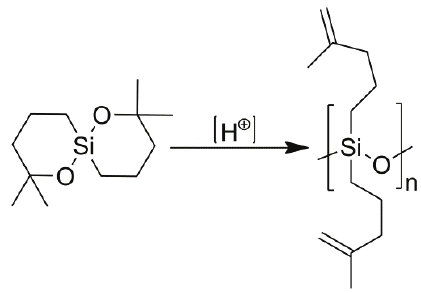
Figure 23. The formation of a polysiloxane via a double ring-opening cationic